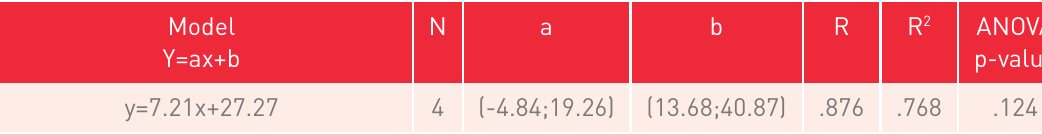
x=LID, b=constant and y=predicted DW